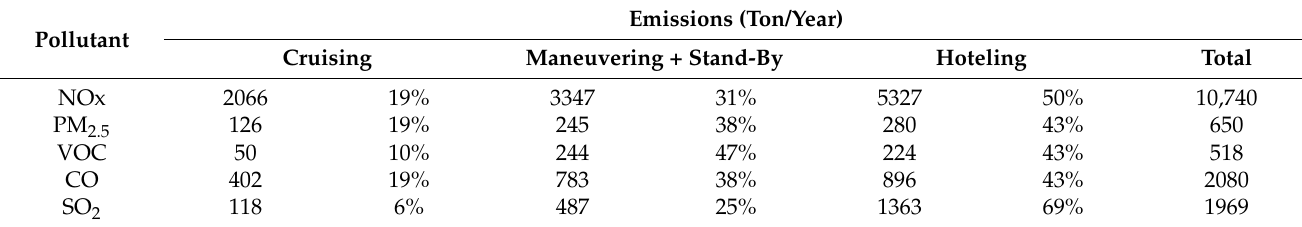
Table A14. Total emissions from vessels (Haifa, BAU 2030).